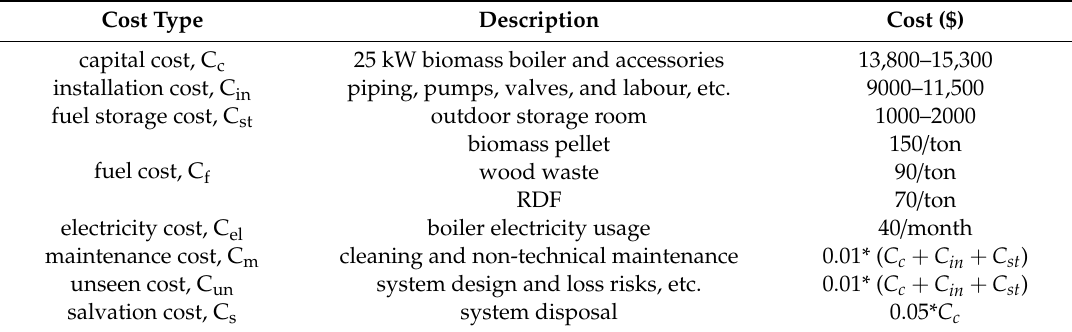
Table 6. List of breakdown costs for biomass boiler heating system [50].